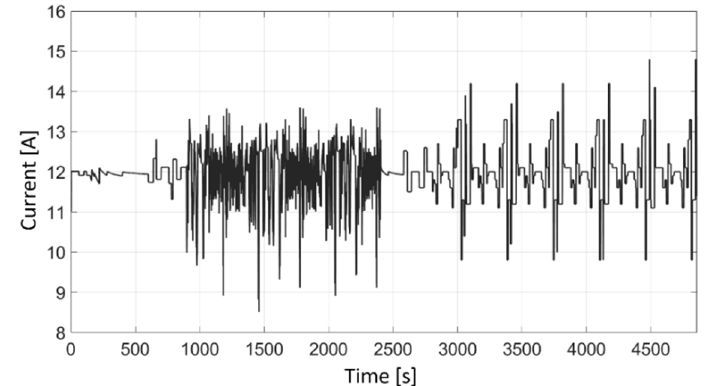
Figure 6. Current profile created to validate the SOH classifier. The profile is replicated until reaching the total duration of 50 h and a number of buffers of 1500 for each class of ageing.